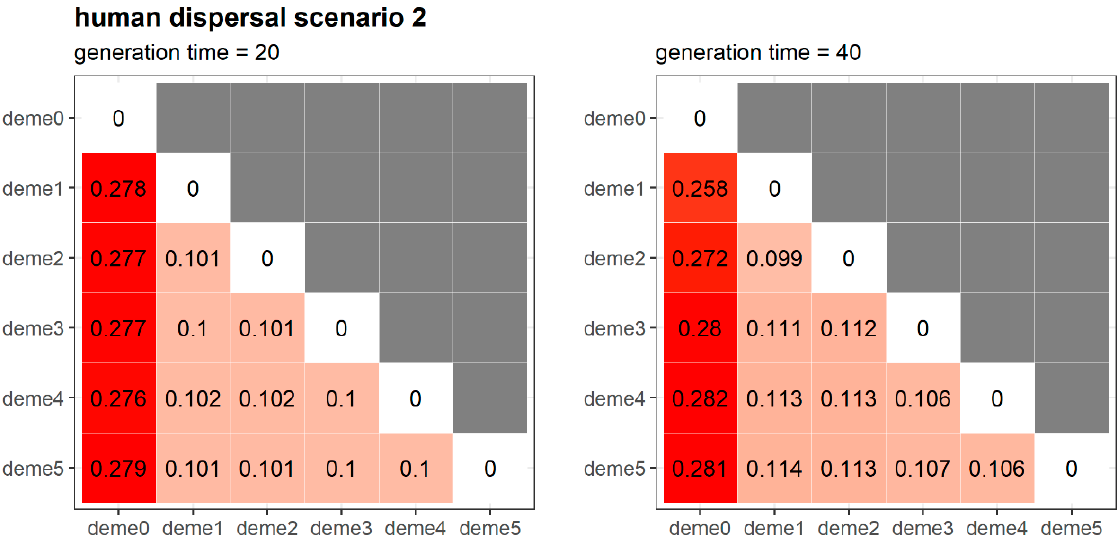
Figure A5. The mean pairwise Fst values calculated across 100 replicate simulations of a post- megafauna Indigenous-mediated dispersal scenario (“hd2” in Table A1). This scenario of Indigenous dispersal assumes that deme0 was established by propagules from deme1 5kya, followed by a symmetric island model of migration between all demes between 5000–200 years ago.